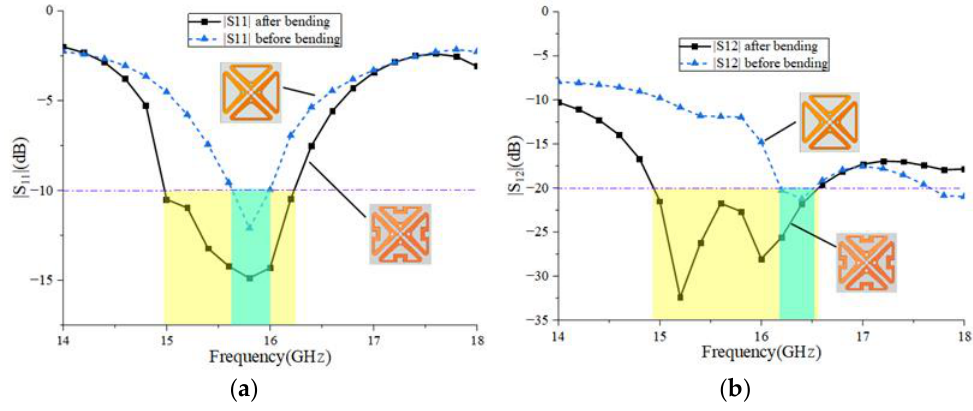
Figure 2. Effect of side bending on antenna bandwidth. ( a ) |S11| and ( b ) |S12|.